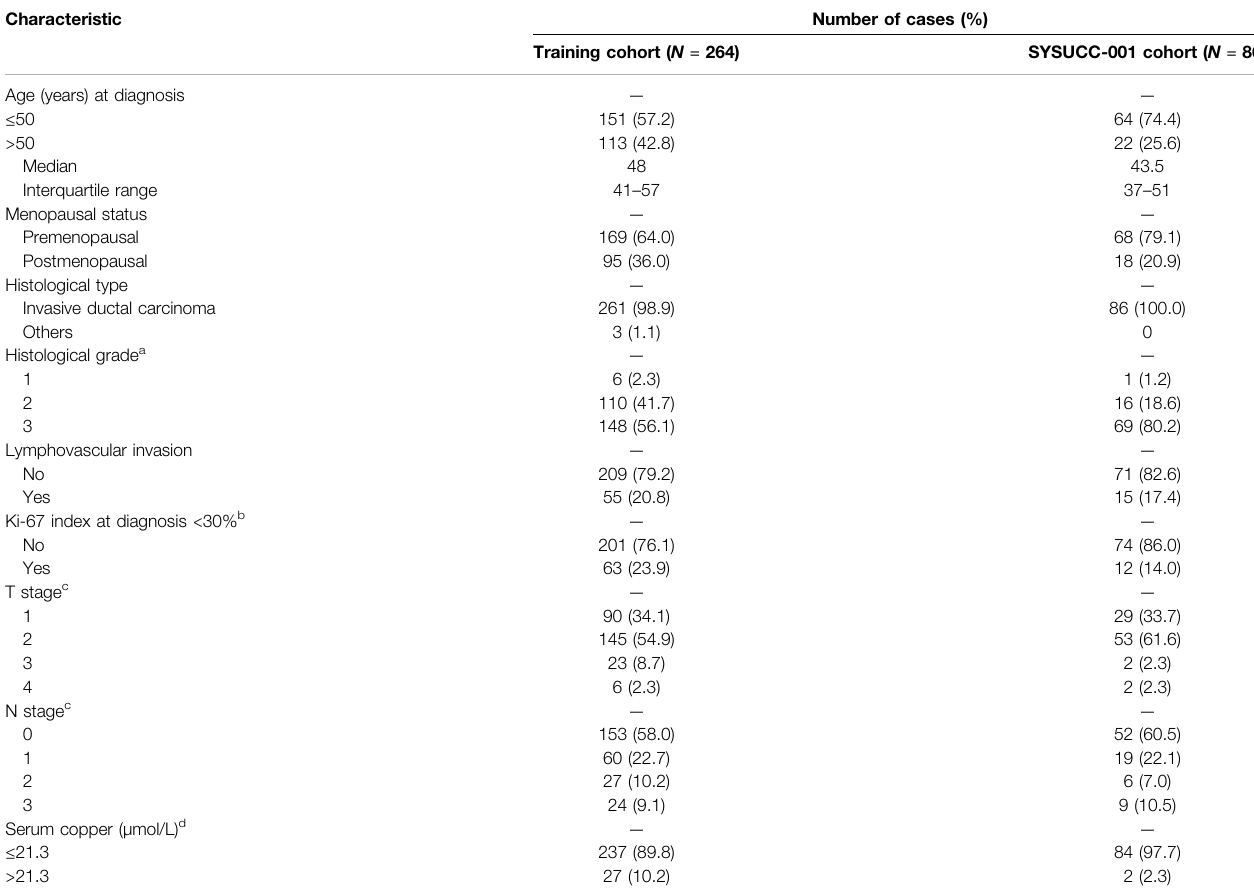
TABLE 1 | Characteristics of patients eligible in this